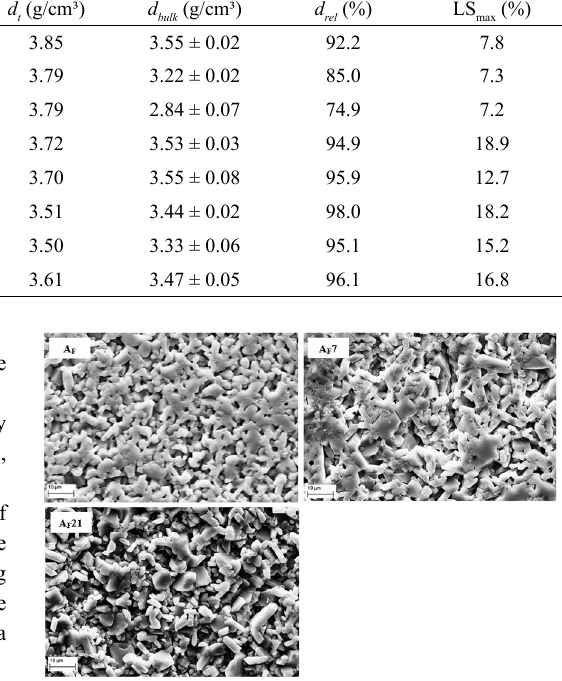
(1,600 ºC/4 h, d F = 0.95) and A rel